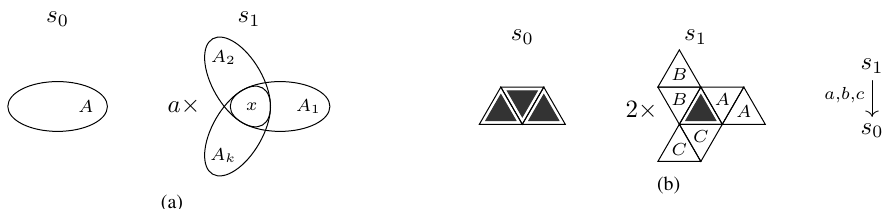
Figure 1: (a) Schematic ( a, b ) proof sequence for the animal A assuming | A | = a + 1 and ak > b . (b) A (2 , 5) -proof sequence for the polyiamond T 3 , 1